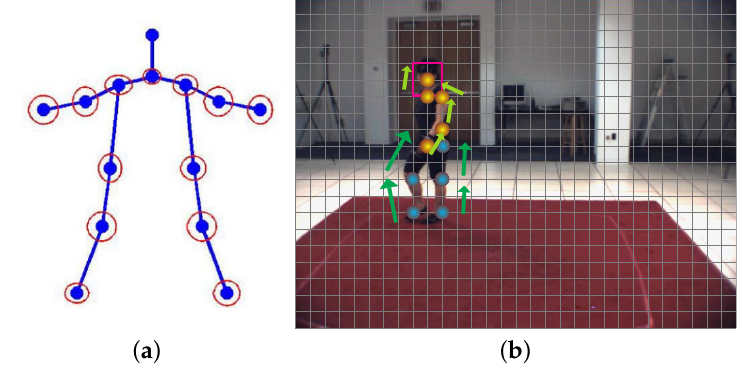
Figure 16. Tree-structured human body model in human pose estimation. ( a ) Tree-structured body model; ( b ) A pose estimation